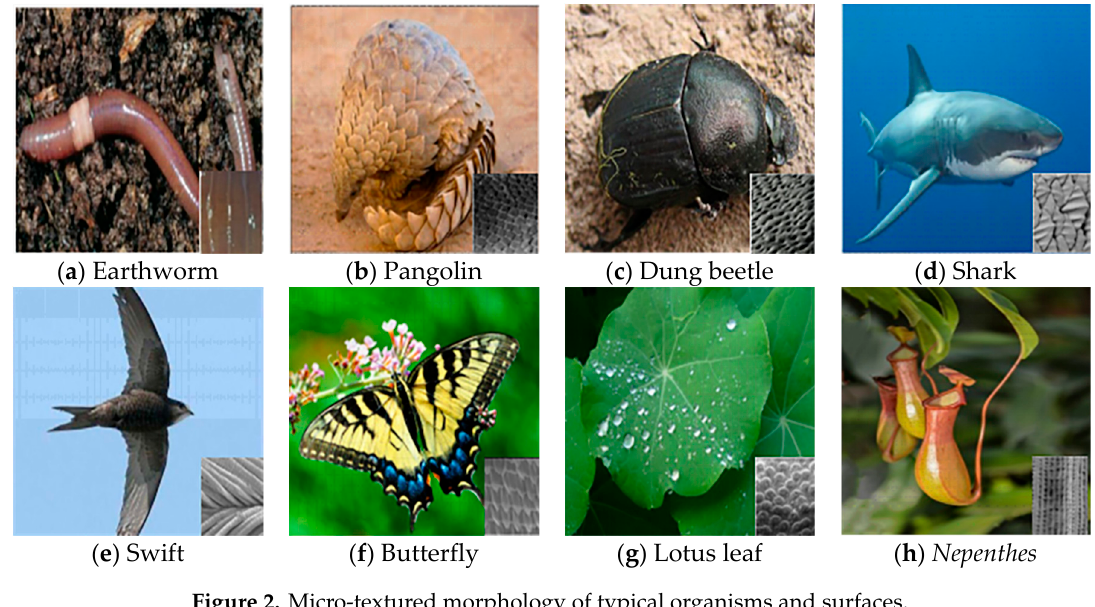
Figure 2. Micro-textured morphology of typical organisms and surfaces.